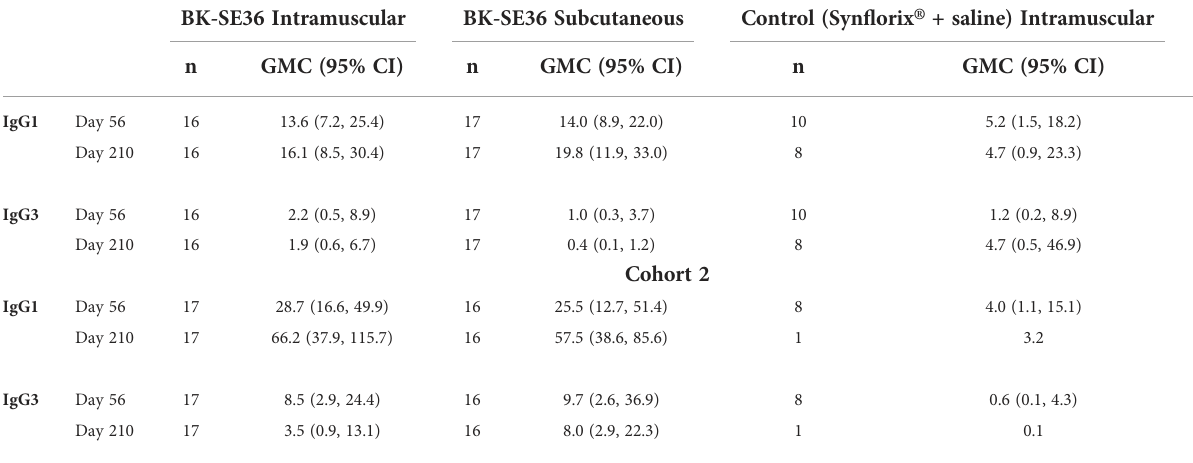
TABLE 5 Concentration of anti-SE36 IgG1 and IgG3 subclasses. Cohort 1 BK-SE36 Intramuscular BK-SE36 Subcutaneous Control (Syn fl orix ® + saline)